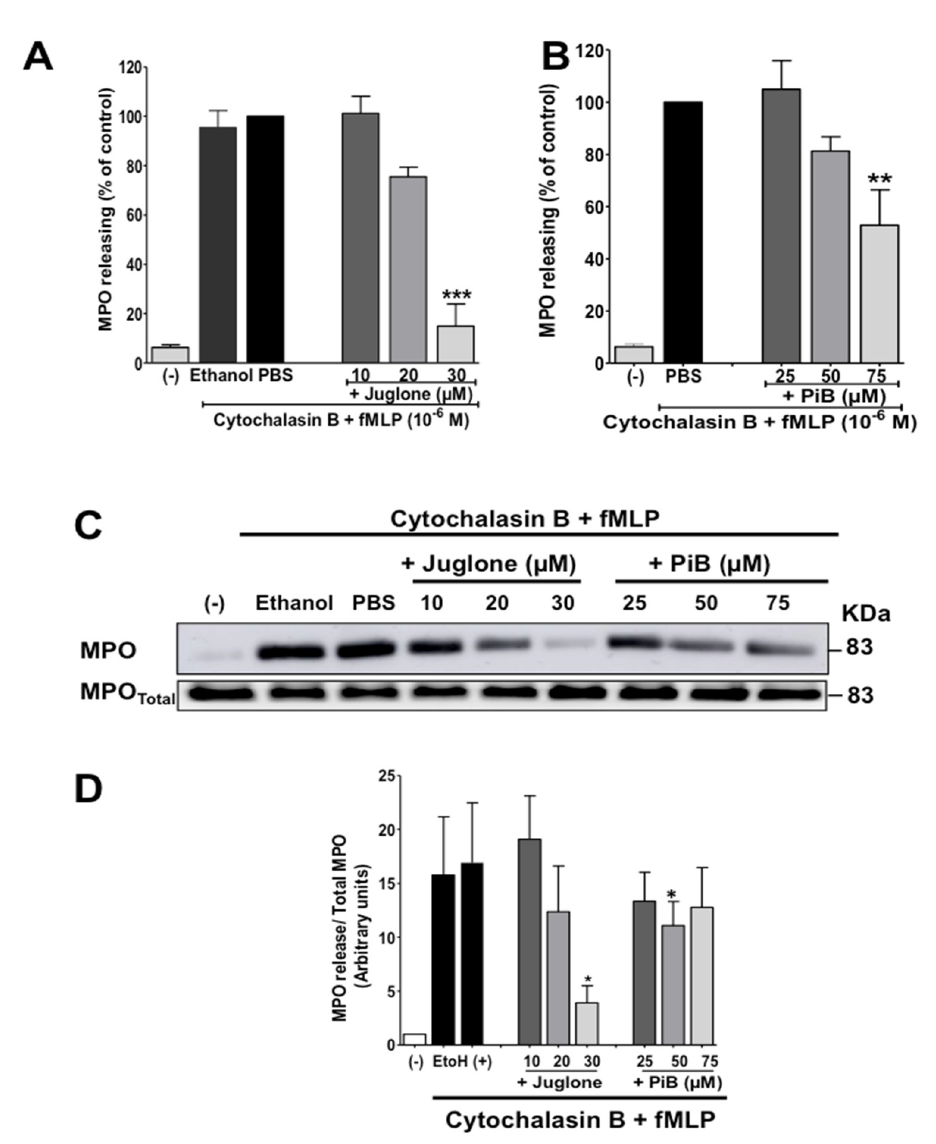
Figure 4. Effect of juglone and PiB on MPO release by human neutrophils. ( A , B ) Cells were pre- treated or not with increasing concentration of Juglone dissolved in ethanol (0, 10, 20, 30 μ M) and PiB (0, 25, 50, 75 μ M), then with cytochalasin B (5 μ g/mL) for 5 min before stimulation with fMLP (10 − 6 M). Control cells were treated with ethanol (0.001% or PBS), then cytochalasin B for 5 min and stimulated by fMLP in the same conditions. After centrifugation the supernatant is recovered to measure MPO activity using the spectrophotometric method as reported in the methods section. ( C ) Equal amounts of supernatant samples and neutrophil pellets were subjected to SDS-PAGE fol- lowed by immunoblot analysis with anti-MPO antibody. A representative Western blot of 4 exper- iments is shown. ( D ) Western blot results were quantified and expressed in arbitrary units (AU). Values are means ± S.E.M. n = 4 (* p < 0.05, ** p < 0.01, *** p < 0.001). In order to address the question if Pin1 is also involved in fMLP-induced specific granule release, we studied the release of NGAL a marker of specific granules detecting it by Western Blot using a specific antibody. Results show that in combination with cyto- chalasin B, fMLP induced release of NGAL in the extracellular media and that juglone and PiB inhibited NGAL protein release from specific granules (Figure 5). These data corrob- orate with the previous results and suggest that Pin1 controls fMLP-induced neutrophil